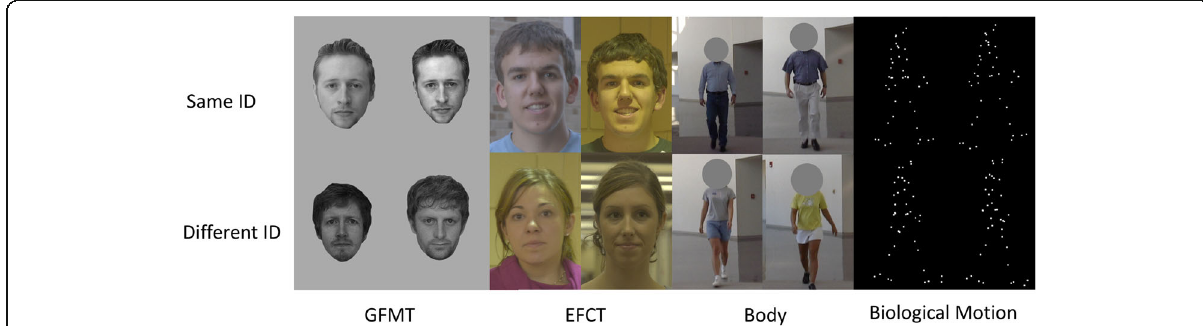
Fig. 1 Example images from the Glasgow Face Matching Test (GFMT), Expertise in Facial Comparison Test (EFCT), Body Task and Biological Motion Task. The top row shows examples of same-identity pairs; the bottom row shows examples of different-identity